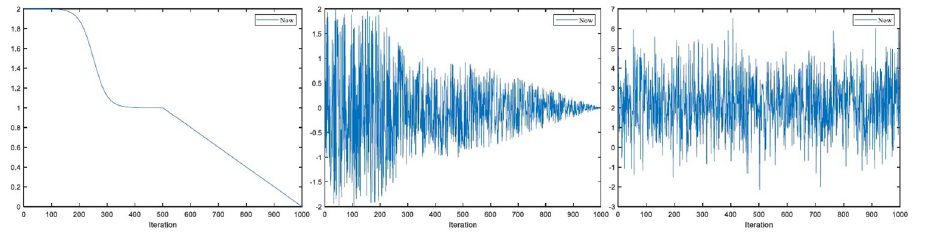
! ! -value and C -value under 1000